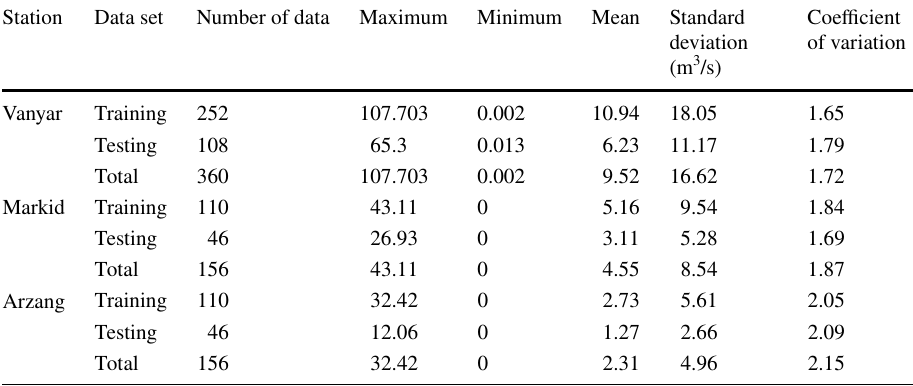
river flow data from Ajichay